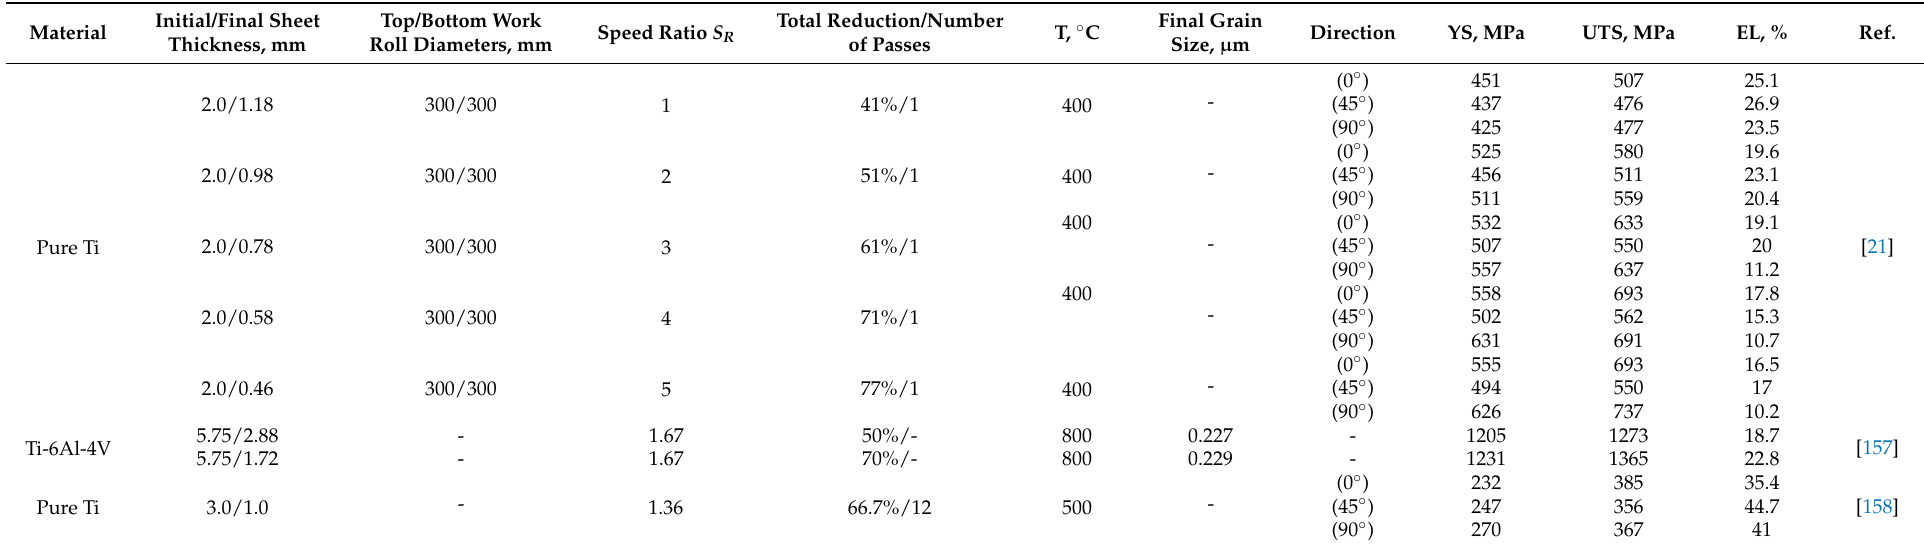
Table 9. Experimental data related to asymmetric warm rolling of Ti alloys.